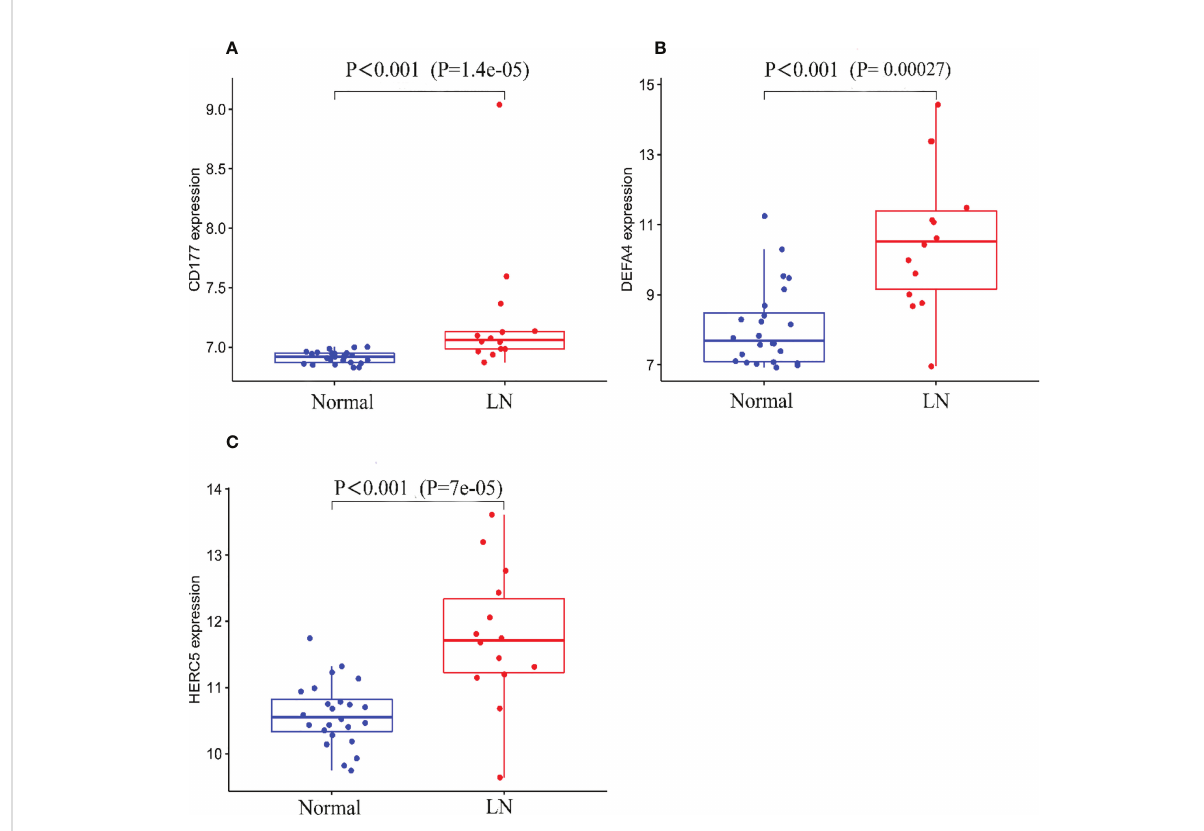
FIGURE 5 Expression of the three biomarkers in the validation group GSE81622 dataset. (A) CD177; (B) DEFA4; (C)